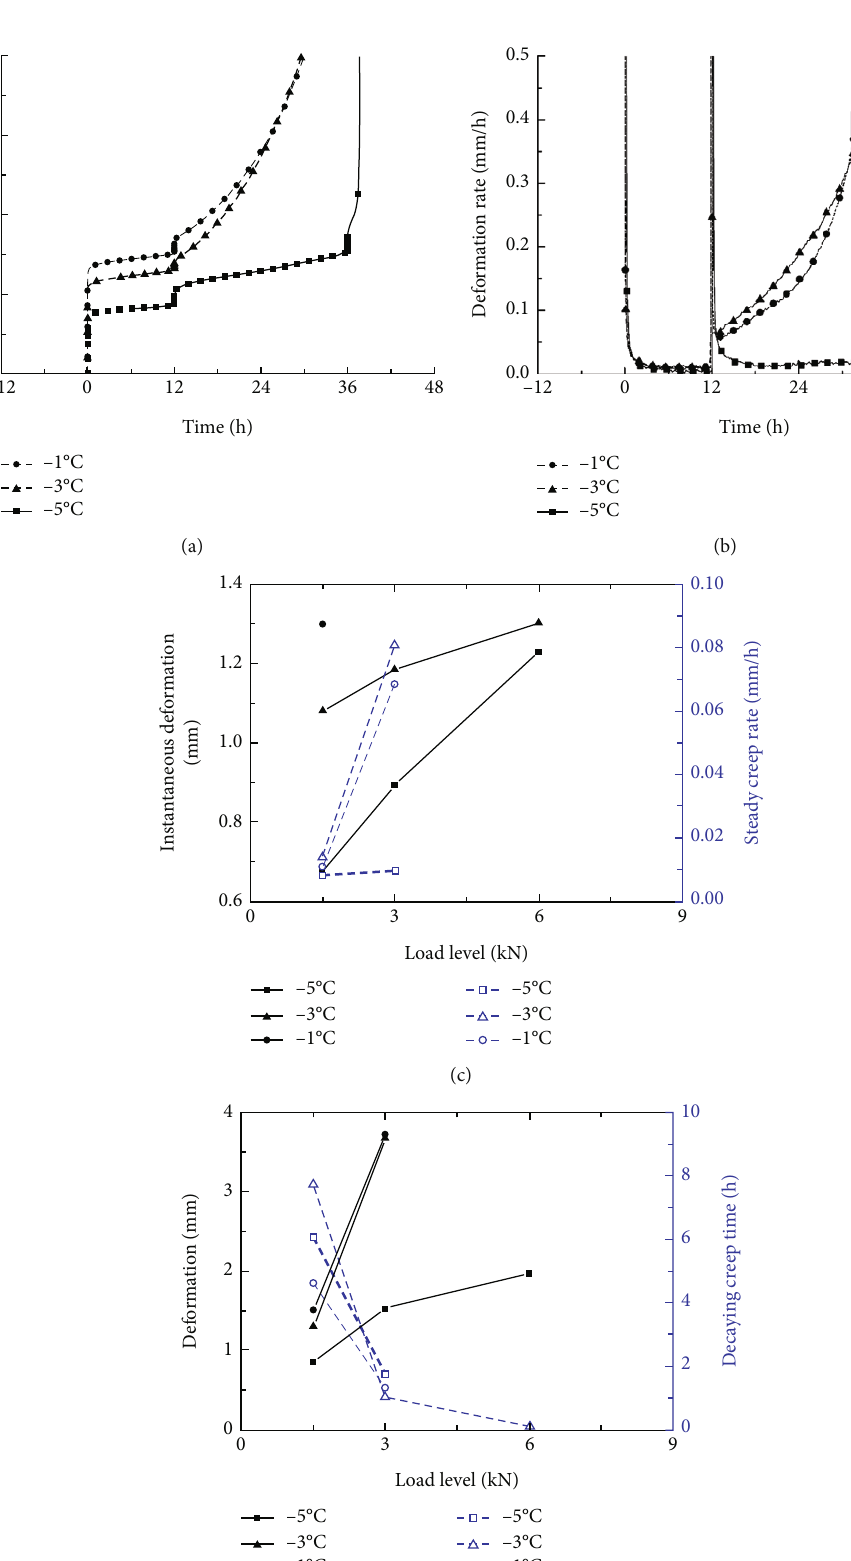
Figure 8: Creep parameters of ice-pile interfaces subjected to di ff erent given